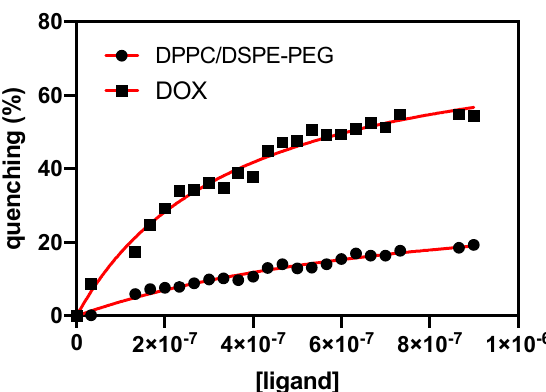
Figure 13. HSA fluorescence quenching (%) as a function of increasing doxorubicin concentration in free form and loaded in DPPC/DSPE-PEG-based liposomes. A nonlinear fit according to Equation (8) is presented (red lines).